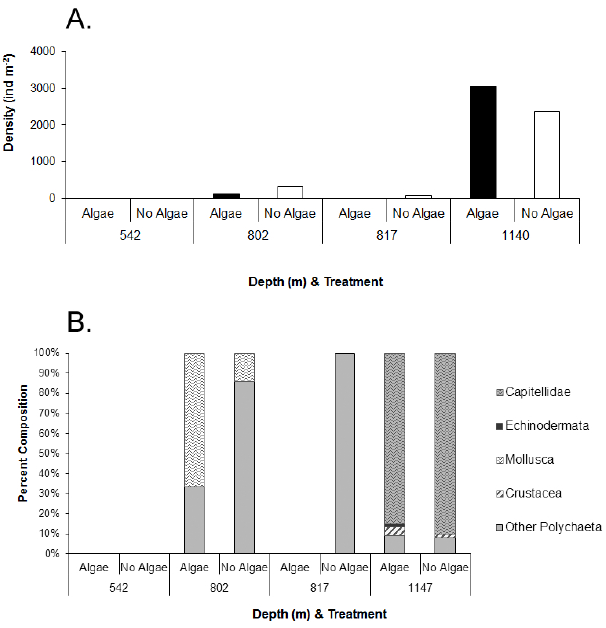
Fig. 8. (A) Comparison of average metazoan macrofaunal density in colonization trays with and without 13 C/ 15 N-labeled phytodetritus on the W. Indian margin. (B) Comparison of metazoan macrofaunal composition in colonization trays with and without phytodetritus on the W. Indian margin. Each bar reflects data combined for 2 trays. See Table 1 for tray deployment periods and locations.